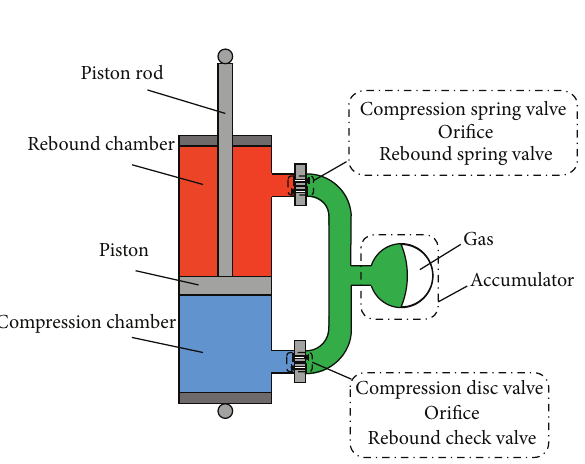
Figure 2: The structure of double-tube damper.